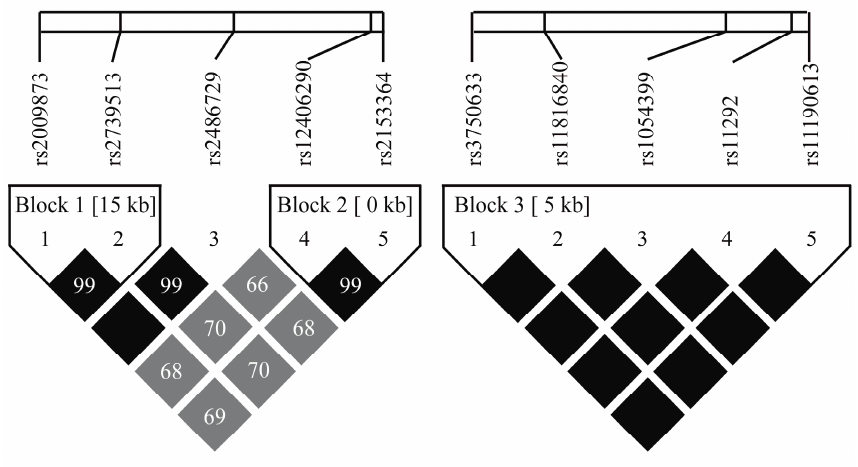
Figure 1. Linkage disequilibrium (LD) plot constructed by Haploview 4.2